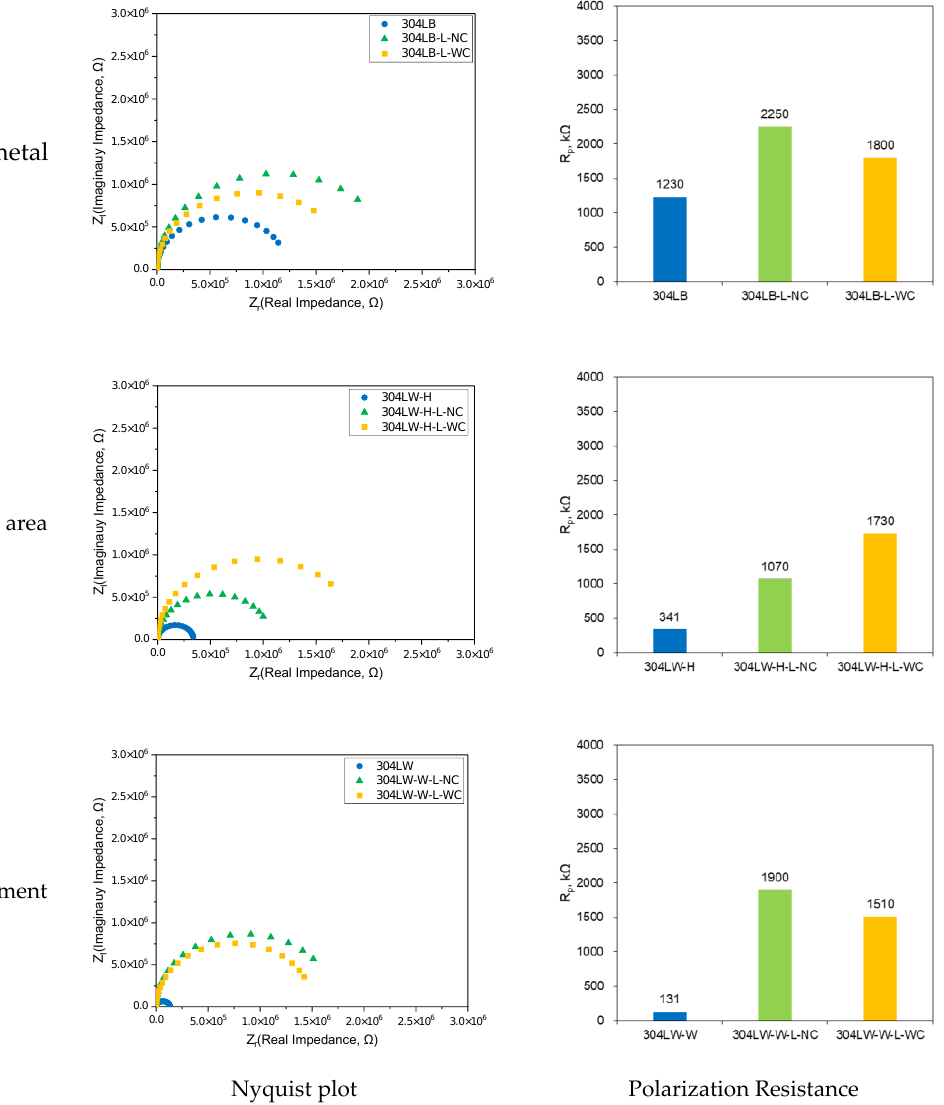
Figure 11. Effect of laser peening on the AC Impedance of 304L-cross-section area (30 °C, deaerated 1% NaCl). 1%